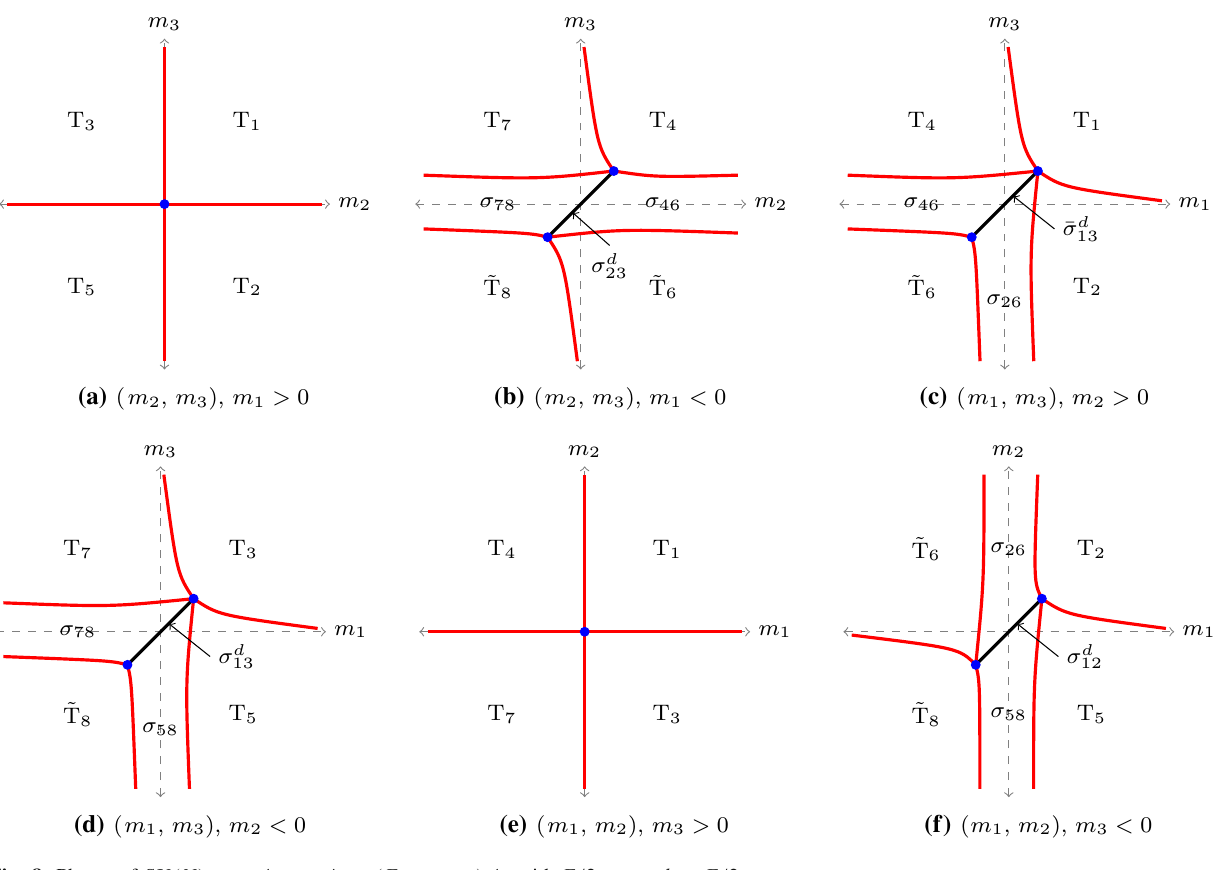
Fig. 8 Phases of SU ( N ) k + p ψ 1 + q ψ 2 + ( F − p − q )ψ 3 with F / 2 − p ≤ k < F / 2 − q